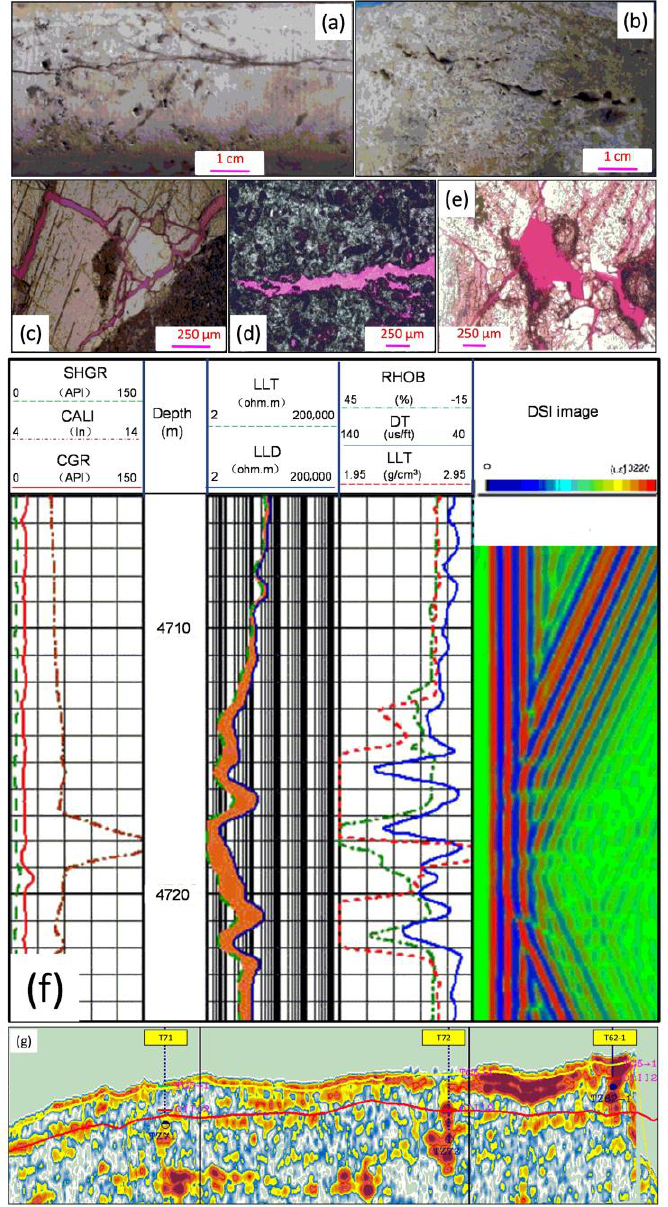
Figure 8. Photographs of Ordovician carbonate reservoirs. ( a ) open vertical fractures and dissolution pore-vug, T242, 4501 m, core; ( b ) dissolution pores and vugs along fractures, T62 − 1, 4894.5 m, core; ( c ) open fracture network, T24, 4687.75 m, casting thin section; ( d ) dissolution pores along fractures, T82, 5375.5 m, casting thin section; ( e ) dissolved pores along fractures, T82, 5364.74 m, casting thin section; ( f ) logging image of a fracture-cave reservoir, T58 (after reference [13]; ( g ) The seismic spectral decomposition section of the fracture-cave reservoirs (The “bead-shape” reflection showing large fracture-cave reservoir, see reference